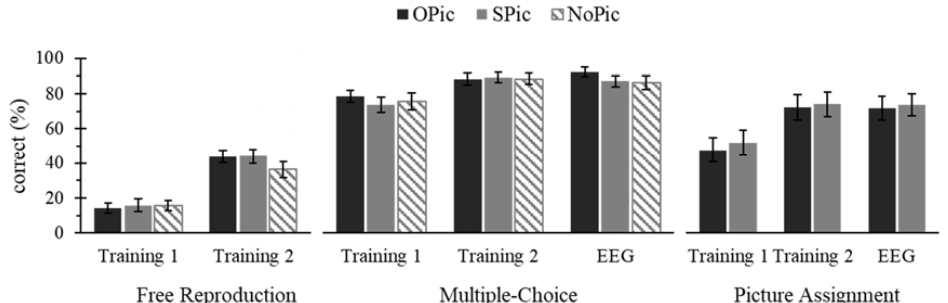
Figure 1. Novel word learning performance. The mean ( ± one standard error for n = 21) learning performance (% correct) for the free reproduction task ( left ); multiple-choice questionnaire ( middle ) and picture assignment ( right ); separately for novel words associated with object (OPic), structure acquired after the EEG